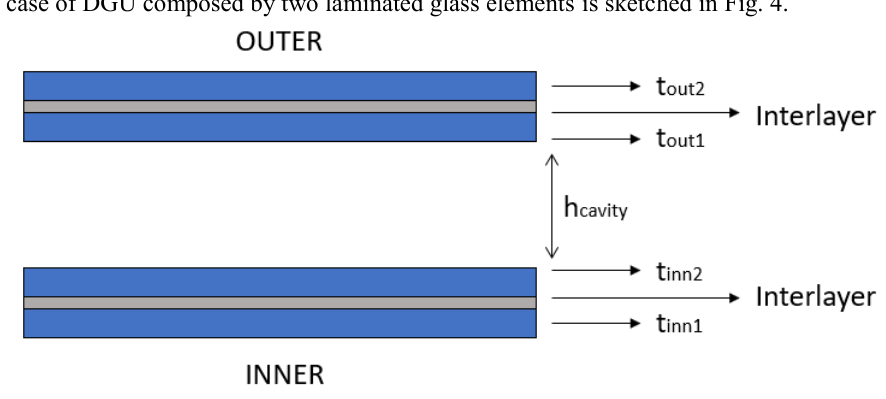
Fig. 4 The most general build-up of the DGU considered in these analyses.